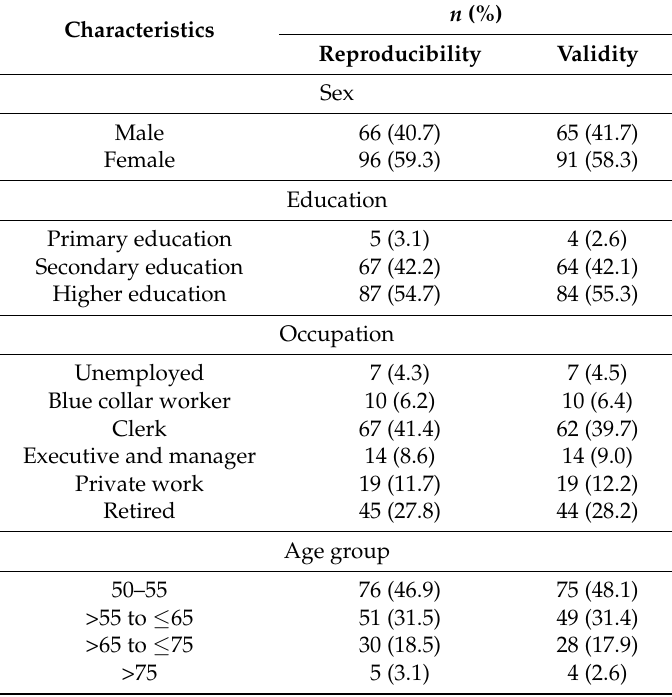
Table 1. Demographic characteristics of the sample, n = 162 for reproducibility and 156 for validity.